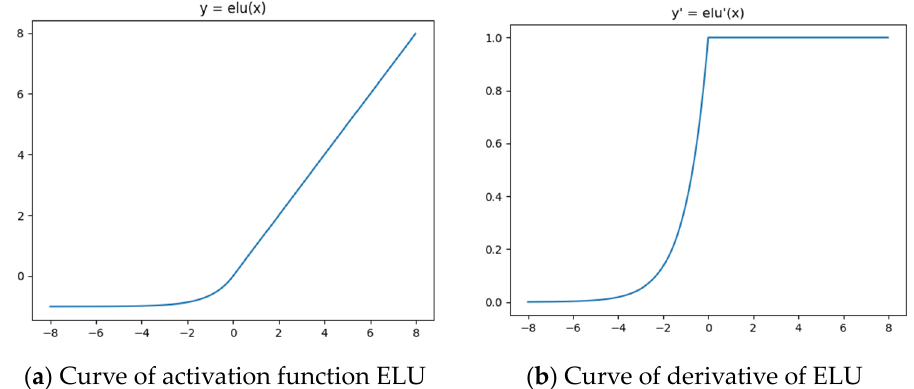
Figure 2. ELU activation function and its derivative.